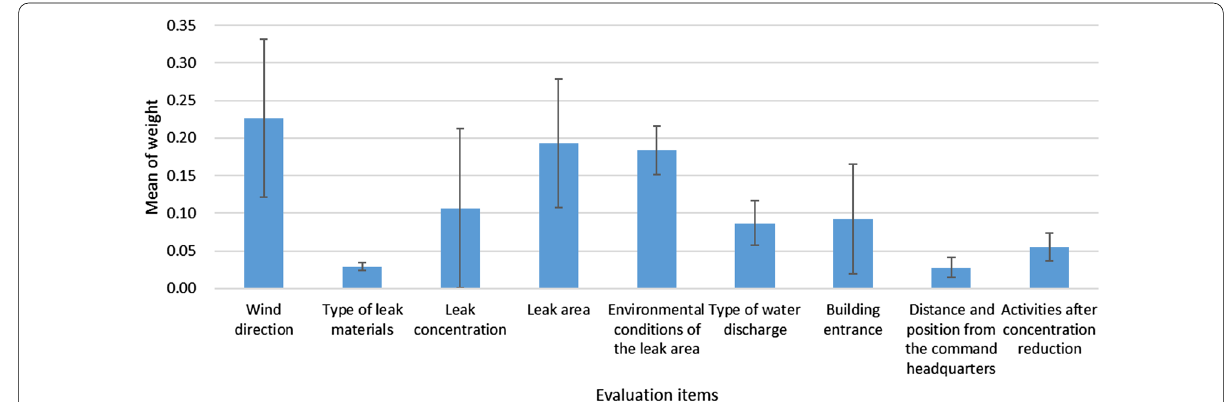
Fig.2 The weight discrimination of the evaluation items in the attenuation activity